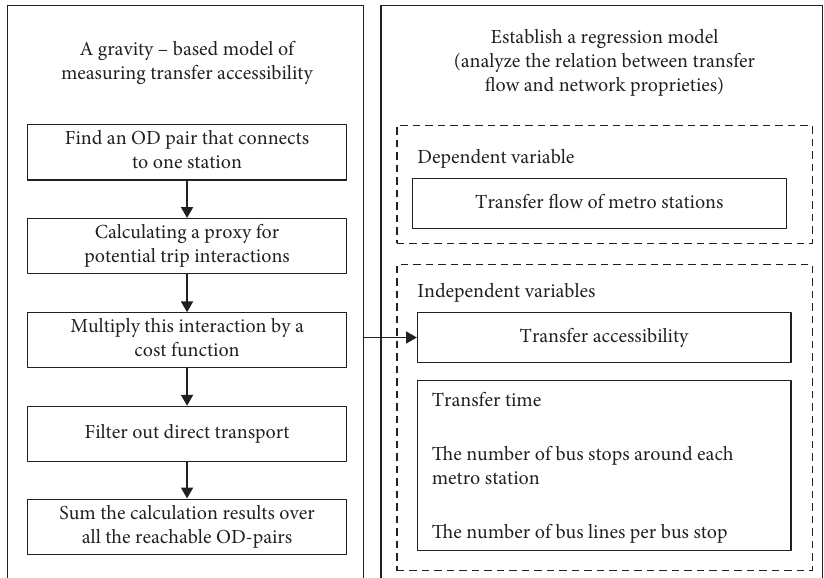
Figure 1: Main components of the developed methodology and overall research design.